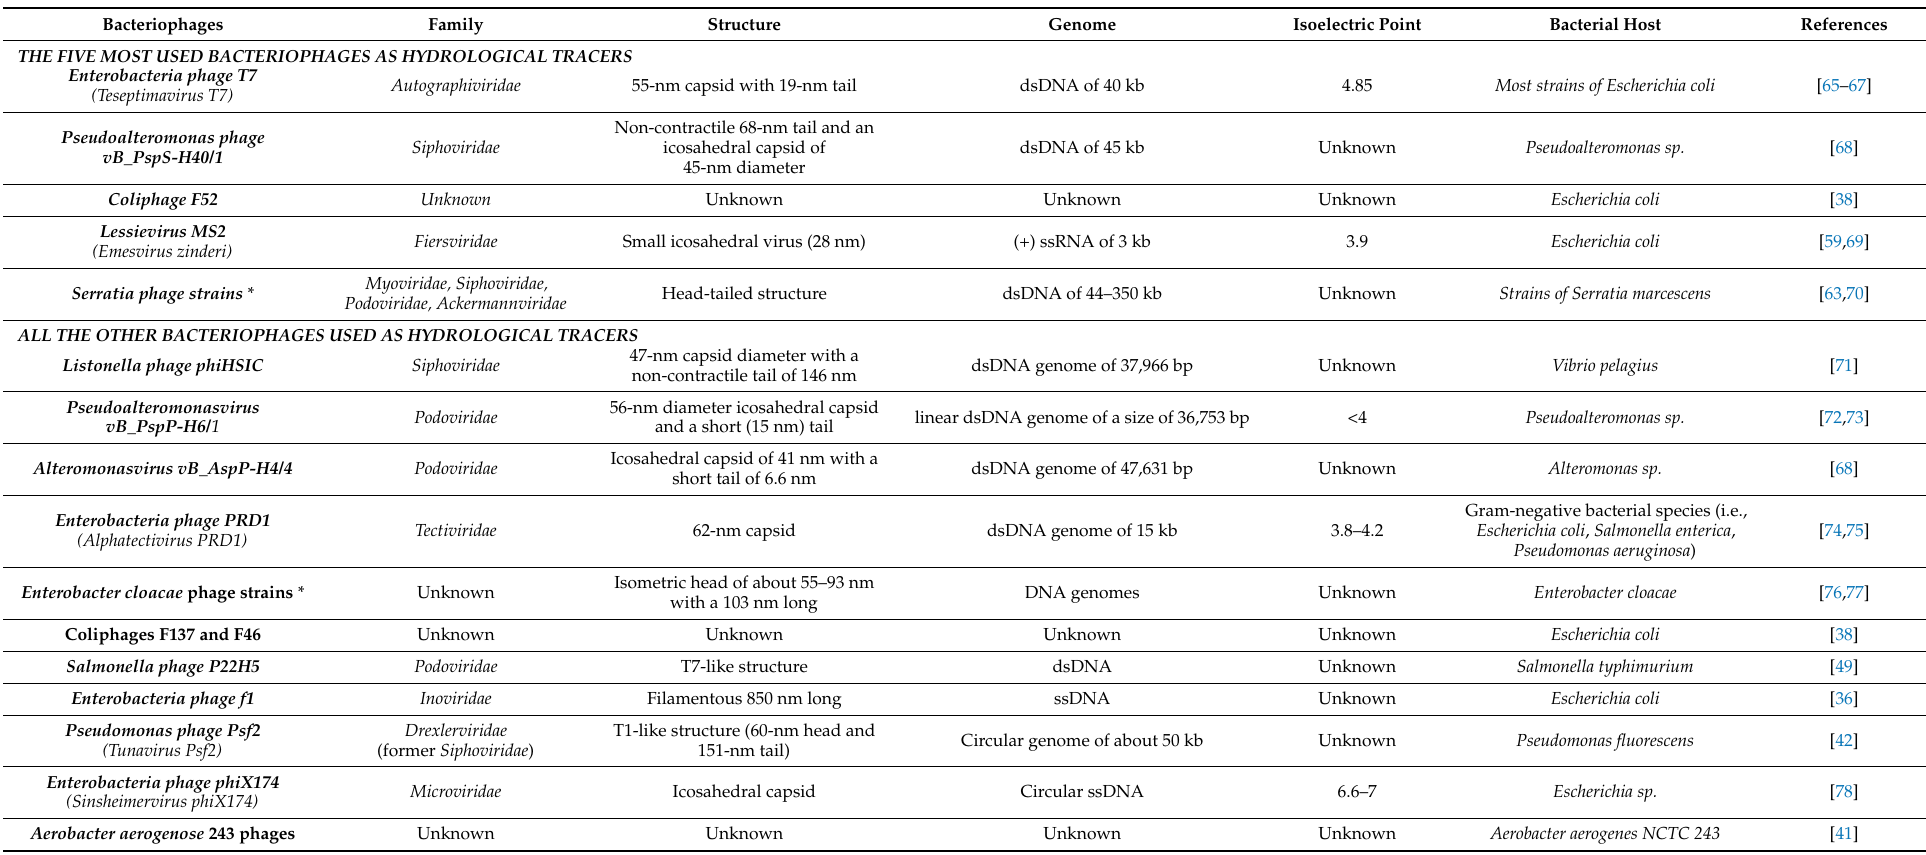
Table 1. Characteristics of all bacteriophages used as hydrological